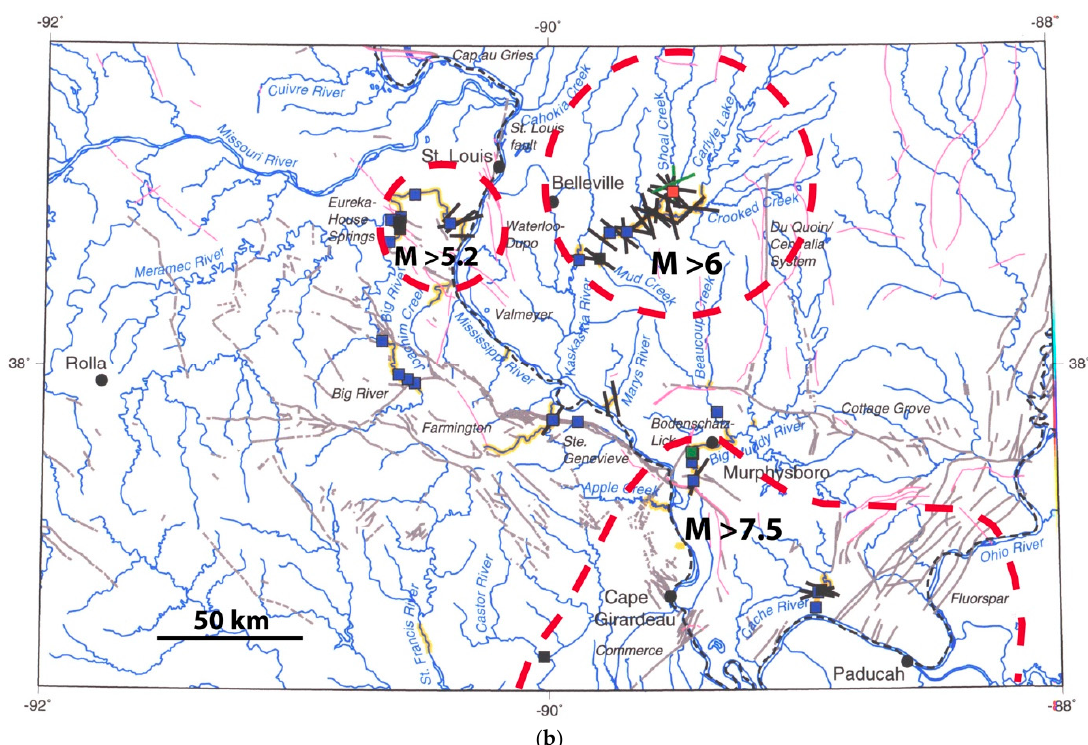
Figure 22. Alternative earthquake scenarios that can explain the distribution of paleoliquefaction features in the greater St. Louis region (modified from [131]); dashed red lines represent possible liquefaction fields: ( a ) M > 7 earthquake centered near Germantown (Illinois) in vicinity of largest liquefaction features on Shoal Creek; ( b ) M > 6 earthquake centered near Germantown, M > 5.2 near St. Louis, and M > 7.5 centered near New Madrid (Missouri). Solid black lines indicate location and strike of dikes, where length of lines represents relative size of dike width. Blue filled squares indicate soft-sediment deformation structures. Red- and green-filled squares represent sand blows and sand sills, respectively.